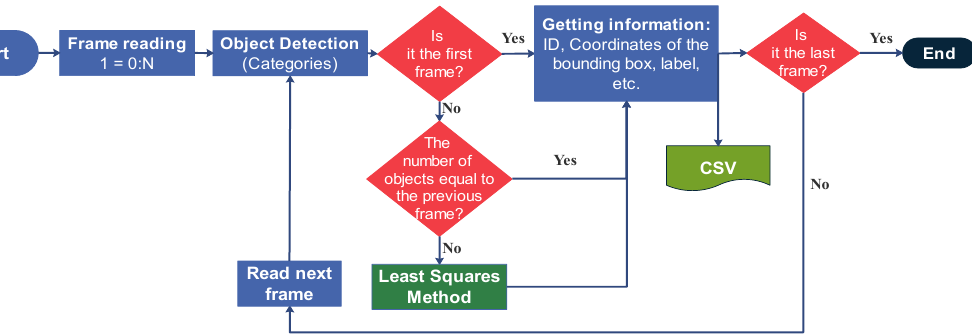
Figure 5. Object tracking block